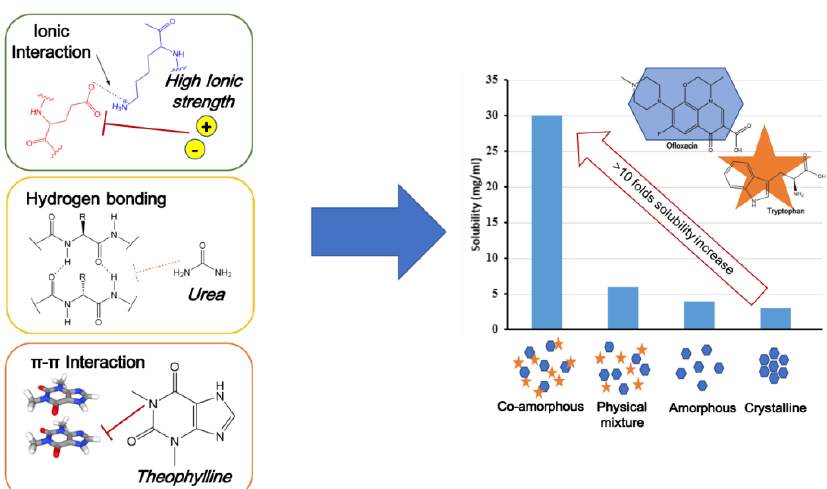
Figure 6. The formation of a co-amorphous system between ofloxacin and tryptophan. Adapted from data presented originally in Ref [65].